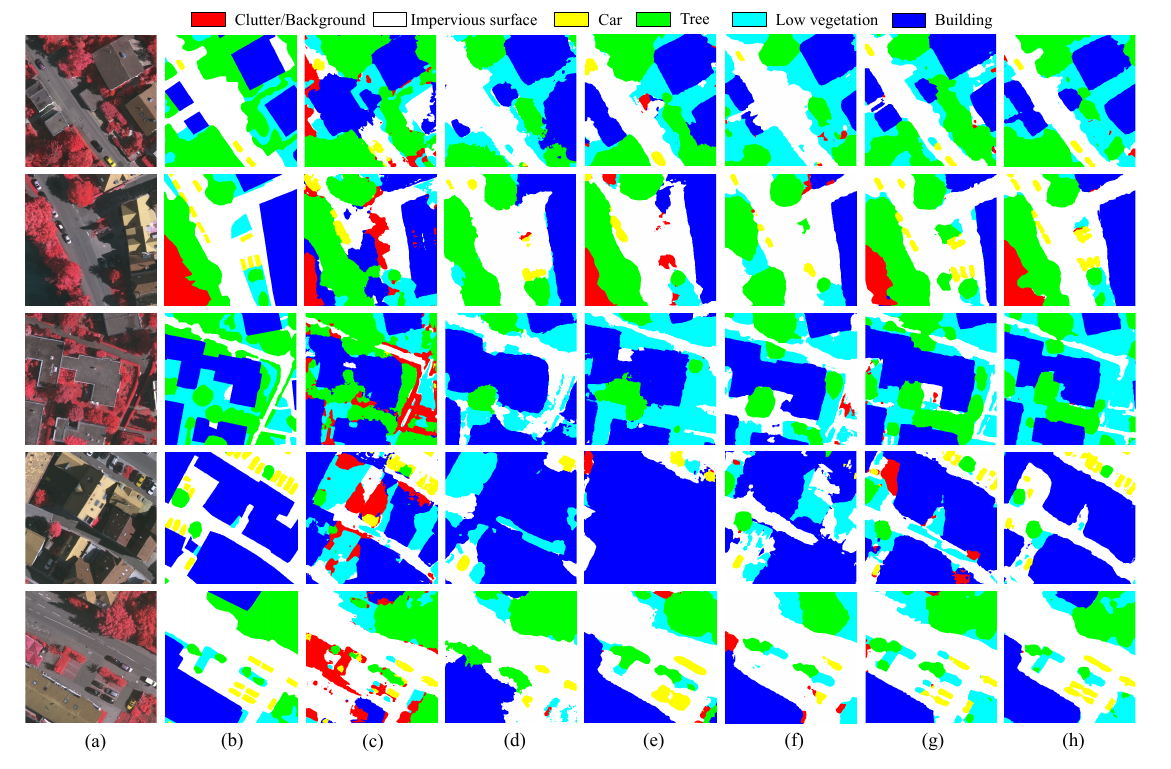
Figure 7. Qualitative results of the cross-domain semantic segmentation on Potsdam RGB → Vai- hingen IRRG. ( a ) Target images. ( b ) Ground truth. ( c ) Baseline. ( d ) GAN-RSDA. ( e ) AdaptSegNet. ( f ) MUCSS. ( g ) RDG-OSA and ( h ) CSC-Aug.